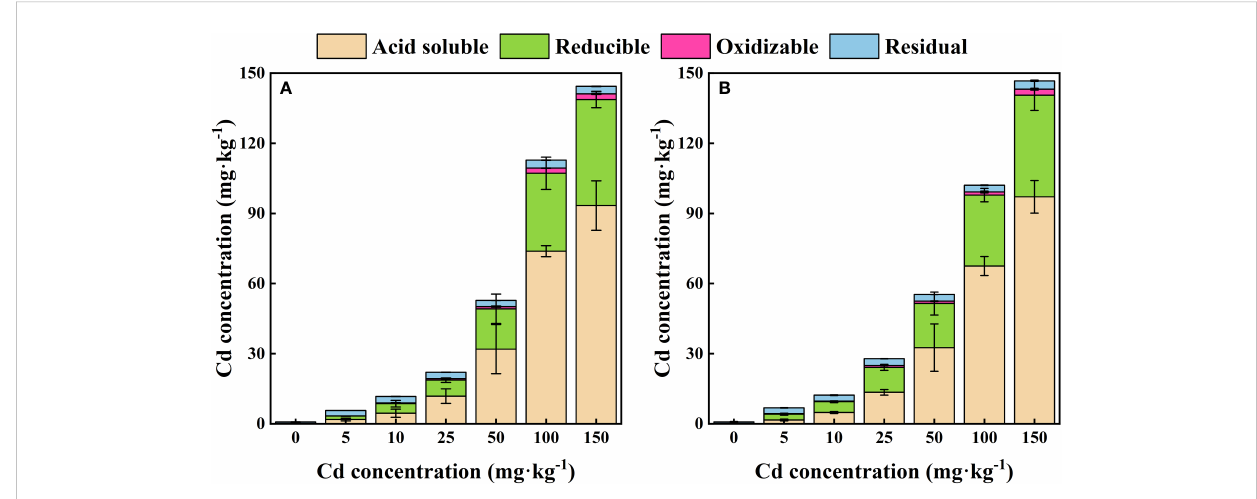
FIGURE 2 Proportion of Cd speciation in the rhizosphere (A) and bulk (B) soil of S.